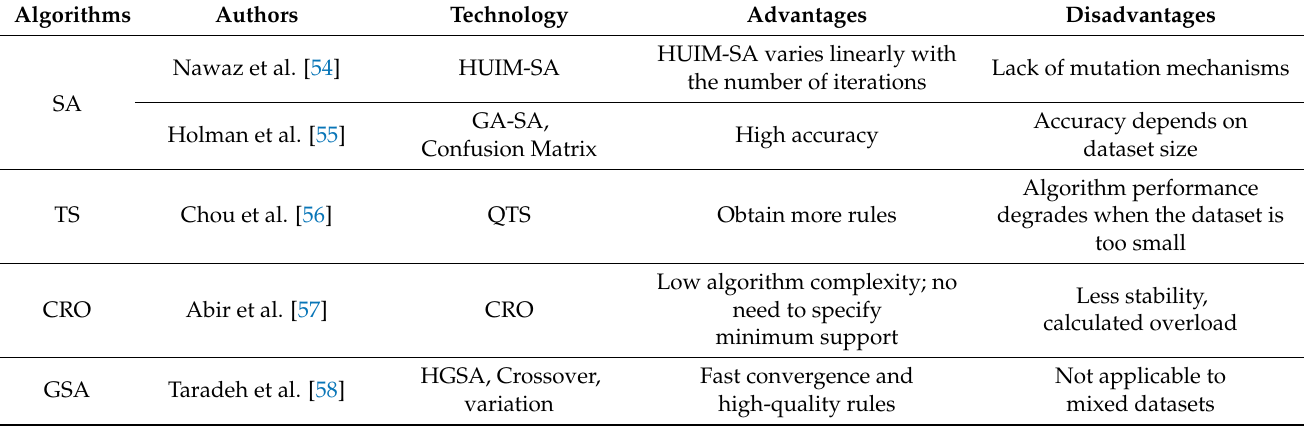
Table 3. ARM, based on the physics-inspired